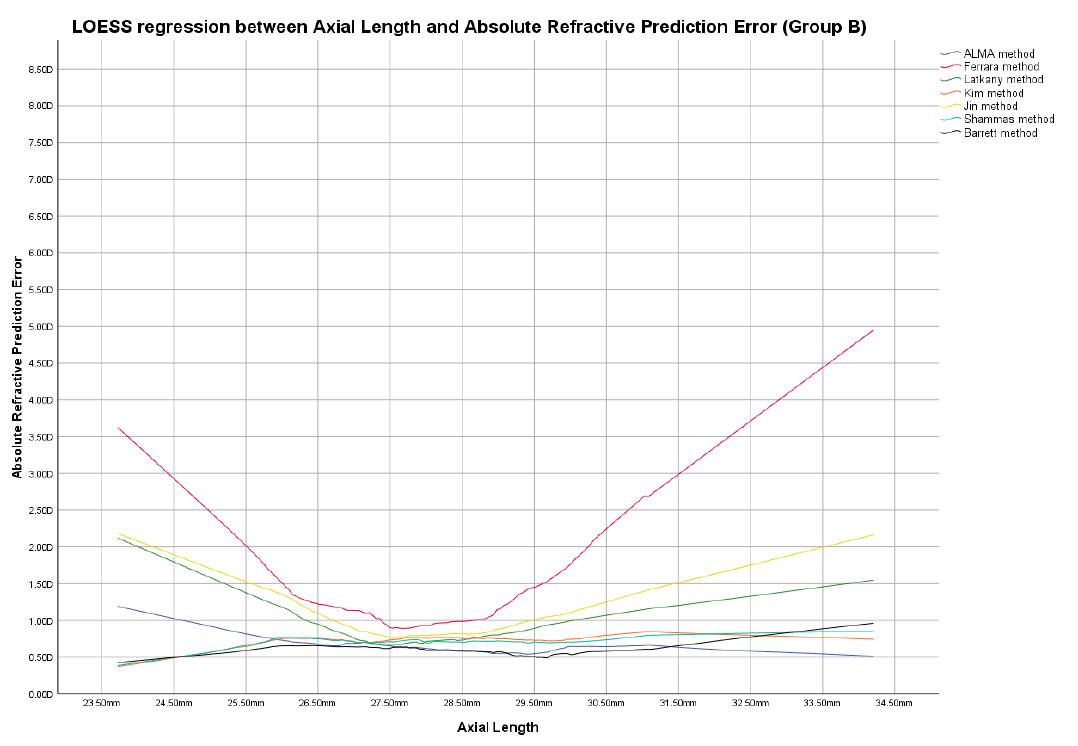
Figure 5. Locally estimated scatterplot smoothing (LOESS) curve between refractive prediction errors generated for each examined formula and the related axial length value. (Group B).